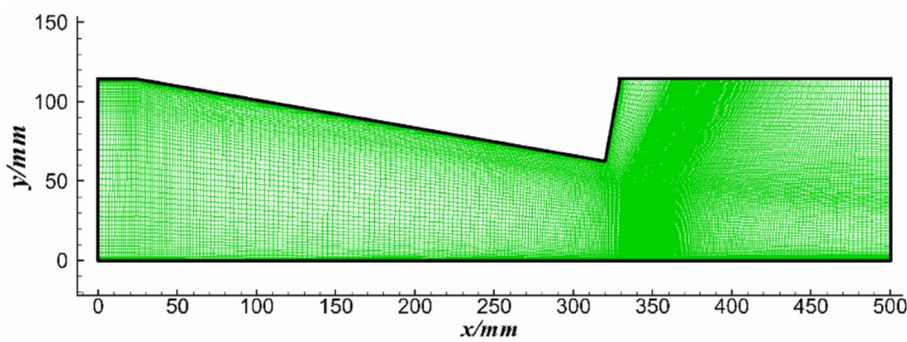
Figure 2. Grid on the symmetry